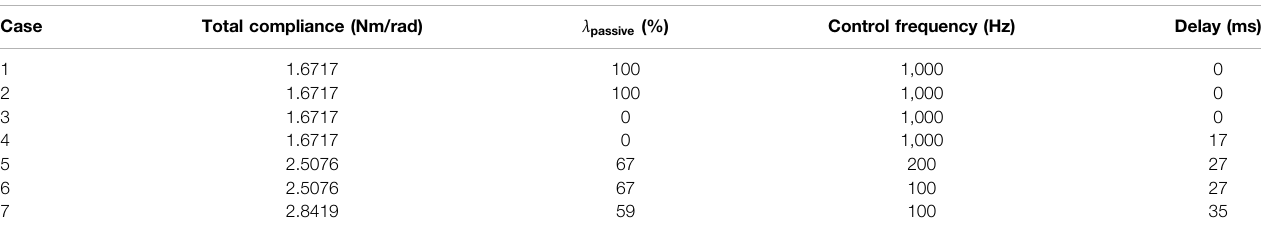
TABLE 1 | Simulation parameters of the quadrupedal robot, with a duty cycle of 100%. Case Total compliance